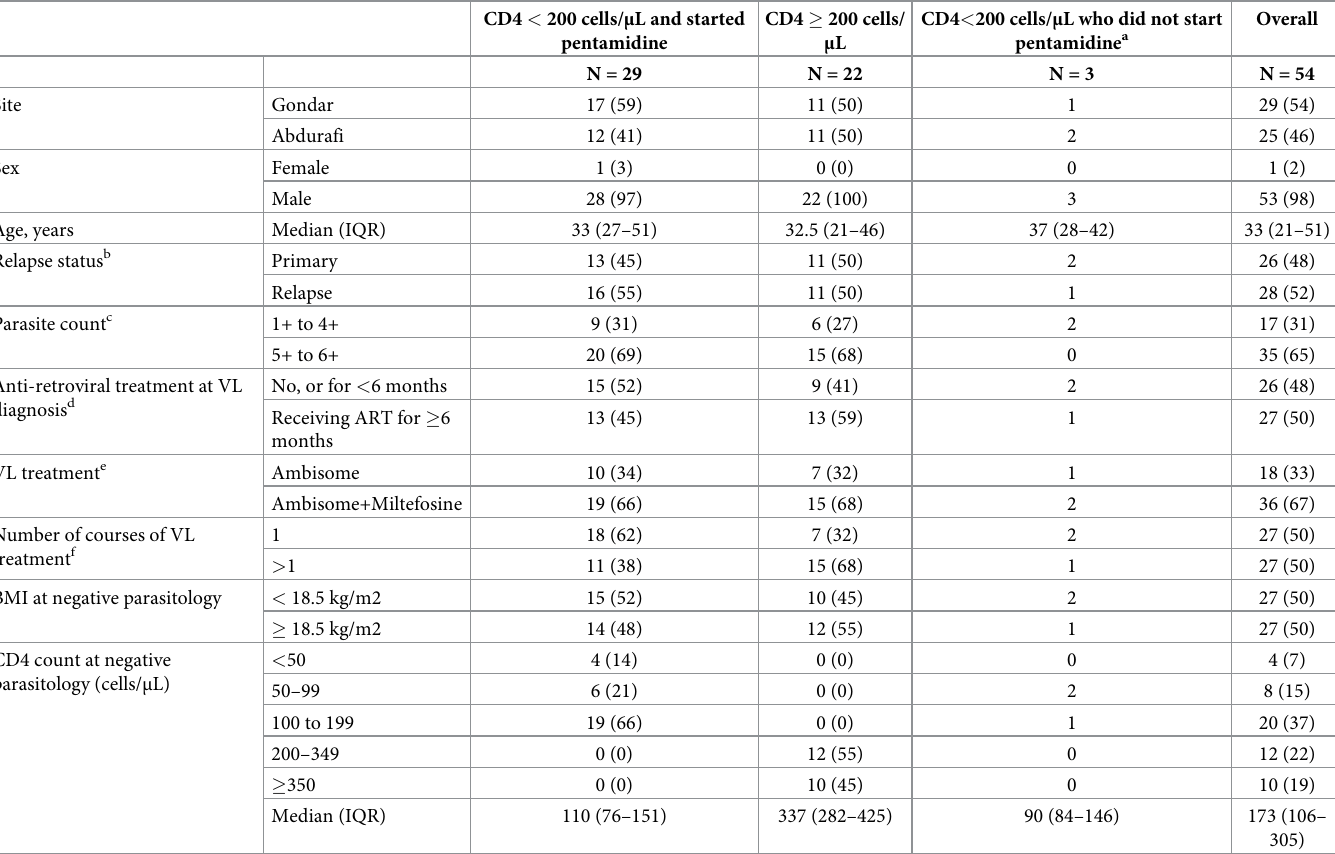
Table 1. Characteristics of patients achieving negative parasitology at end of VL treatment and assessed for eligibility to receive